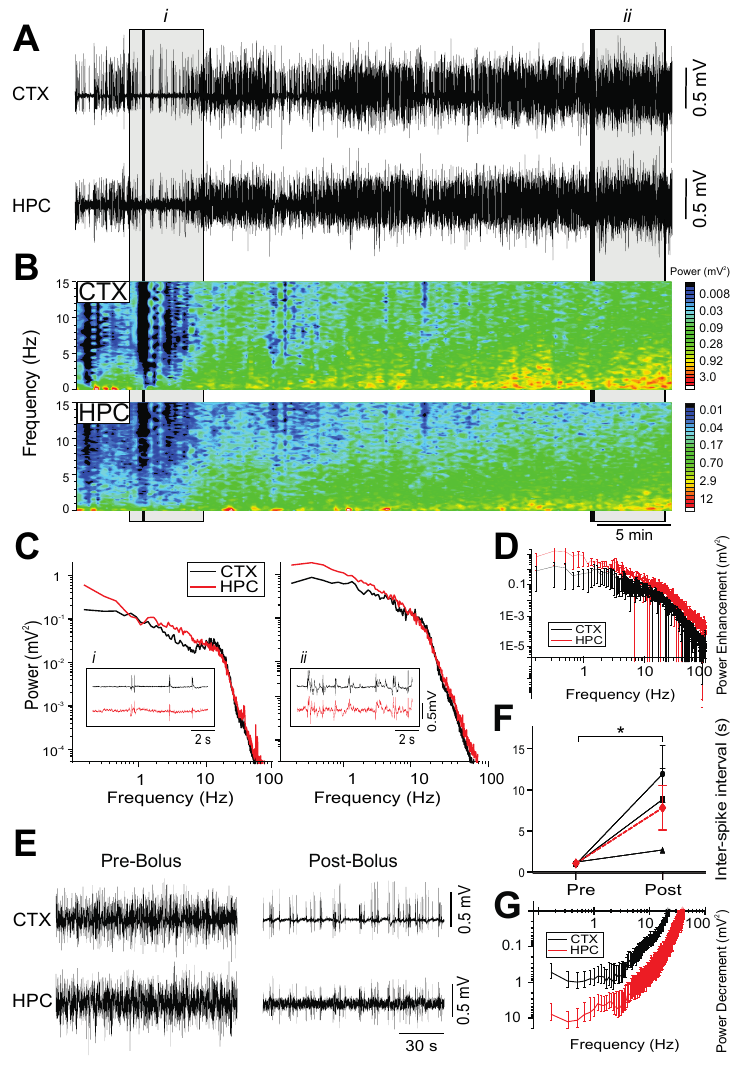
Figure 3. Burst-suppression activity under pentobarbital anesthesia. ( A ): Continuous, 40 min duration cortical (CTX) and hippocampal (HPC) EEG traces. 5 min (grey box) and 10 s (black line) samples from the beginning (i) and end (ii) of the 40 min recording are further analyzed in in C. ( B ): Spectrograms of CTX and HPC EEG traces in A. ( C ): Power spectra of a 5 min selection (grey box) from the EEG traces in A, with an inset of a 10 s raw CTX and HPC EEG trace (black line) from the beginning of A (left panel, i) and end of A (right panel, ii). ( D ): The average difference in spectral power over a 40 min metabolism period, plotted using 2 min samples pre ‐ and post ‐ metabolism to denote the average increment or decrement of power ( n = 3). ( E ): Pre ‐ bolus : A 2 min sample of raw CTX and HPC traces during surgical plane of pentobarbital anesthesia. Post ‐ bolus: A 2 ‐ min sample of activity following a bolus infusion of pentobarbital (6.5 mg). ( F ): The duration of isoelectricity (ISI) in pentobarbital ‐ anesthetized rats significantly increased by 6.8 ± 2.8 s ( n = 3; F (1,503) = 163.5; *, p < 0.0001) following a 6.5 mg bolus dose of pentobarbital (individual animals are represented in black, average in red). ( G ): The average difference in spectral power pre ‐ to post ‐ bolus infusion, plotted using 2 min samples pre ‐ and post ‐ metabolism to denote increment or decrement of power ( n = 3).